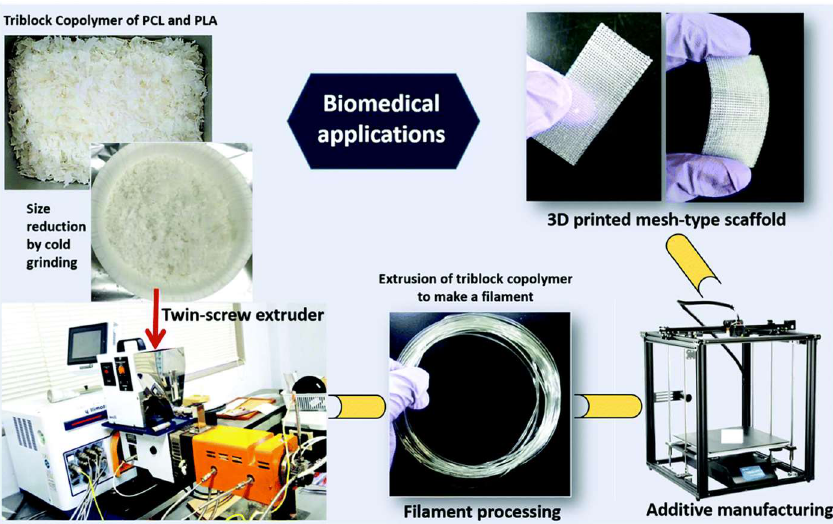
Figure 8. Melt processing of the triblock copolymer (synthesized by the scale-up method) to fabricate the filament which was successfully used for 3D printing a mesh-type scaffold. Reprinted with permission from [100].